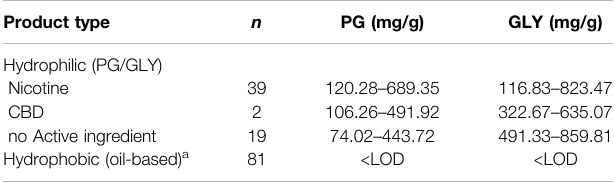
TABLE 2 | Measured propylene glycol (PG) and glycerin (GLY) excipient concentration ranges by product type in EVALI-associated aerosol